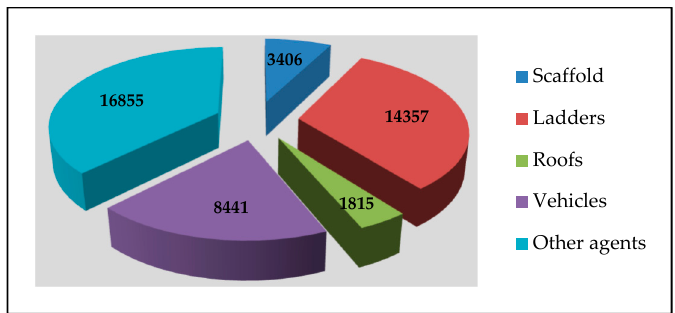
Figure 6. Total injuries due to falls from height in United Kingdom by material agent (2002/03 ‐ 2007/08) [30].